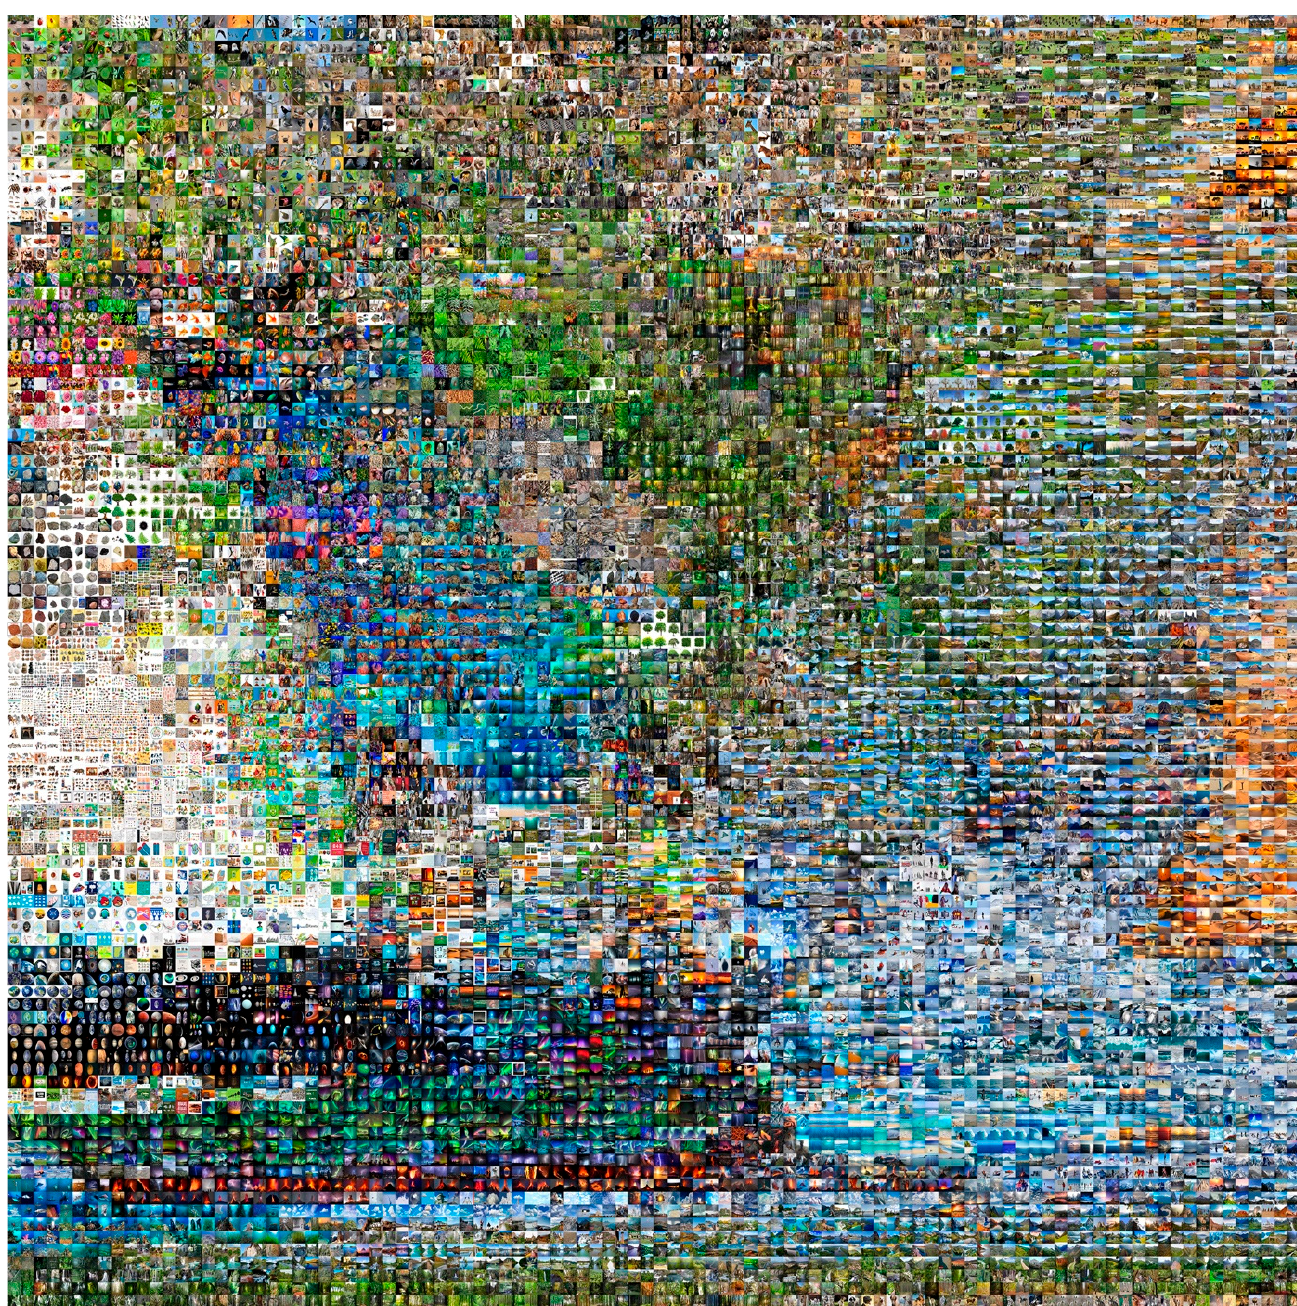
Figure 3. Digital image of 2 × 2 m, which reassigns the locations on a regular grid, but without destroying the neighborhood relations that emerge from the similarity grouping based on t-SNE. © Pilar Rosado.